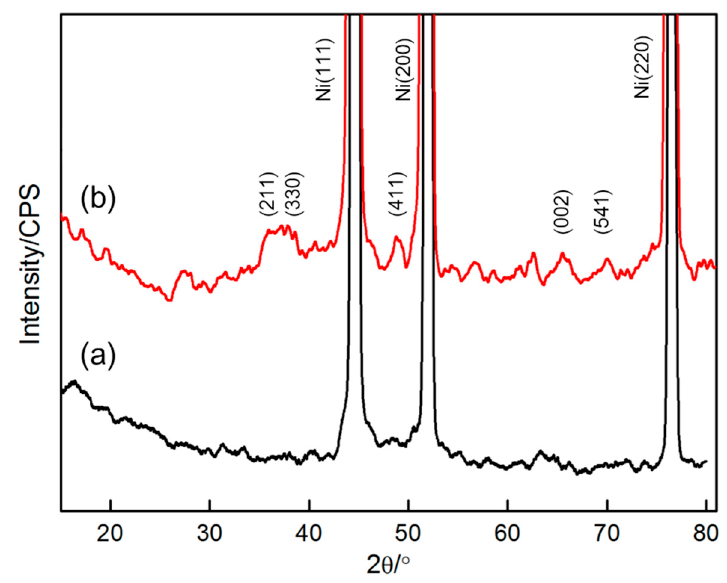
Figure 10. XRD patterns of: ( a ) nickel foam; ( b ) nickel foam covered with the product after depositing for 120 s.